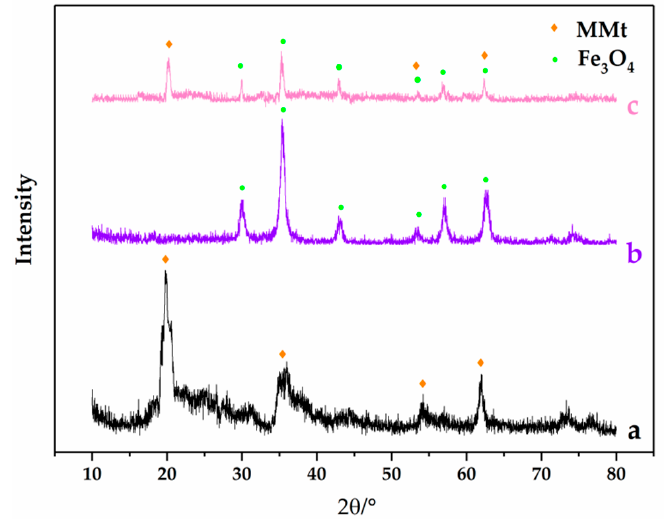
Figure 2. XRD patterns of ( a ) Mt; ( b ) Fe 3 O 4 NPs and ( c ) MFH nanocomposites.